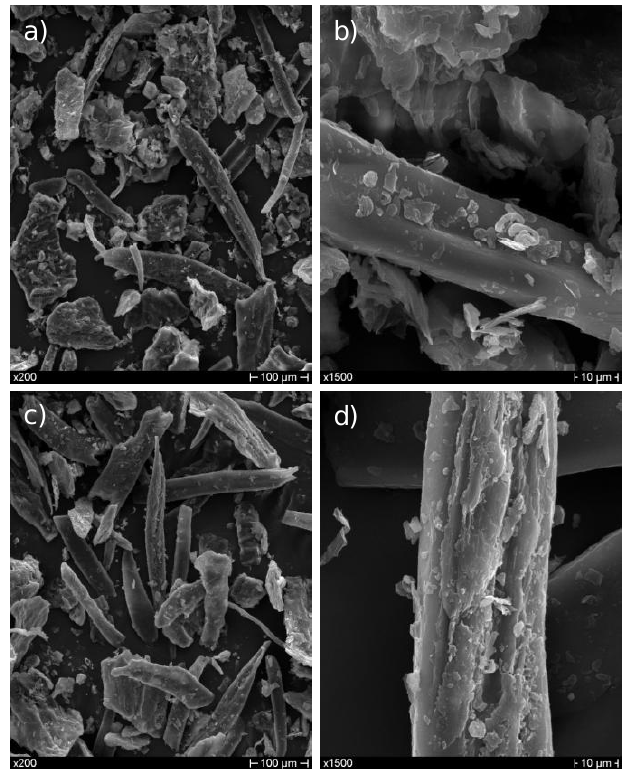
Figure 2. SEM micrographs of ( a , b ) as-received and ( c , d ) extracted CSS.